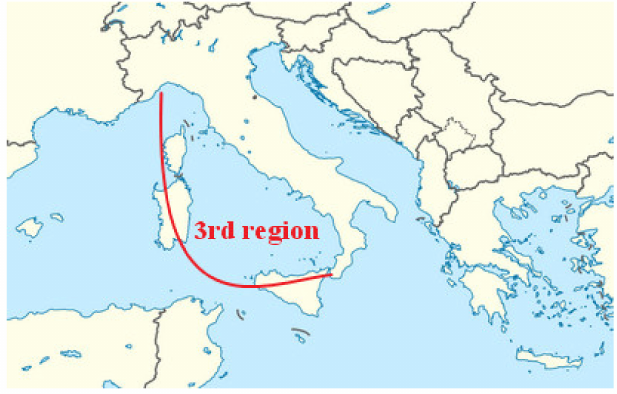
Figure 4. The geographic area taken for the